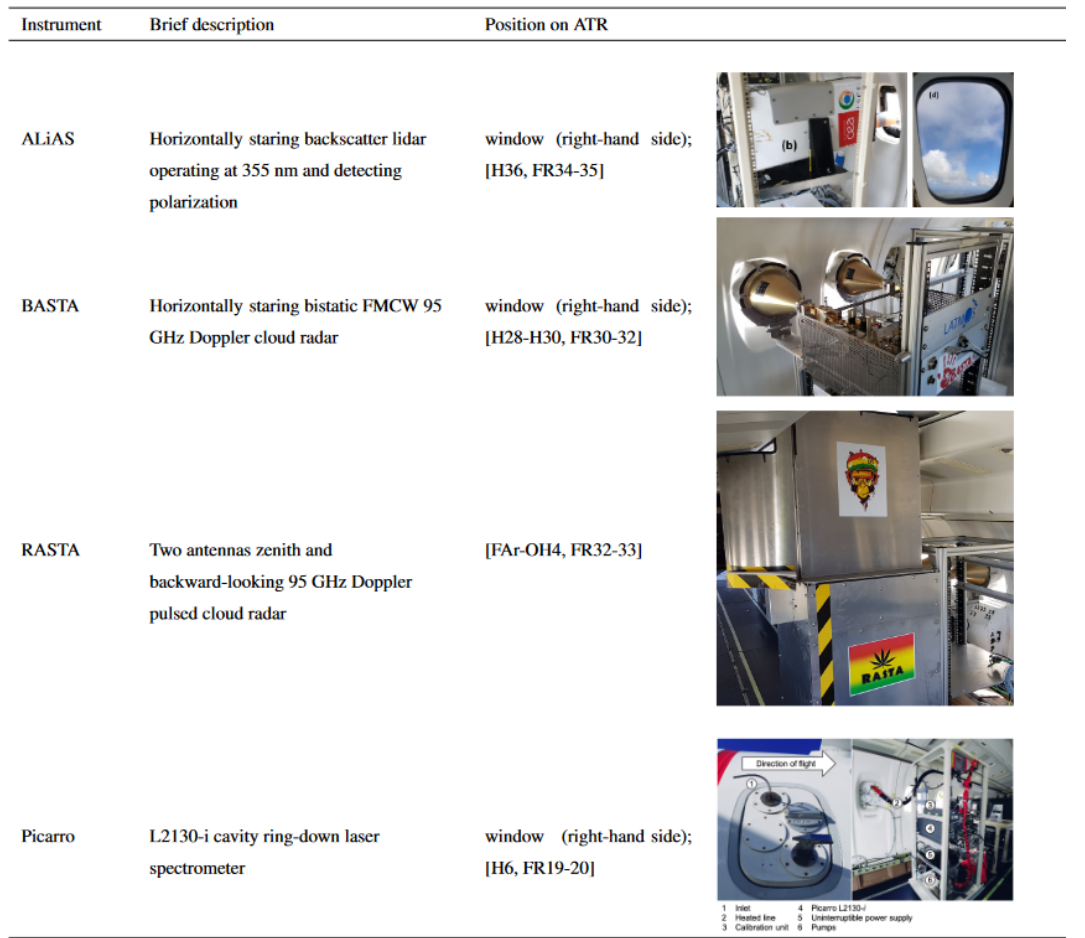
Table 9. Lidar–radar remote sensing and stable isotopologue measurements. See Appendix D for the correspondence between the position on the aircraft and the ATR